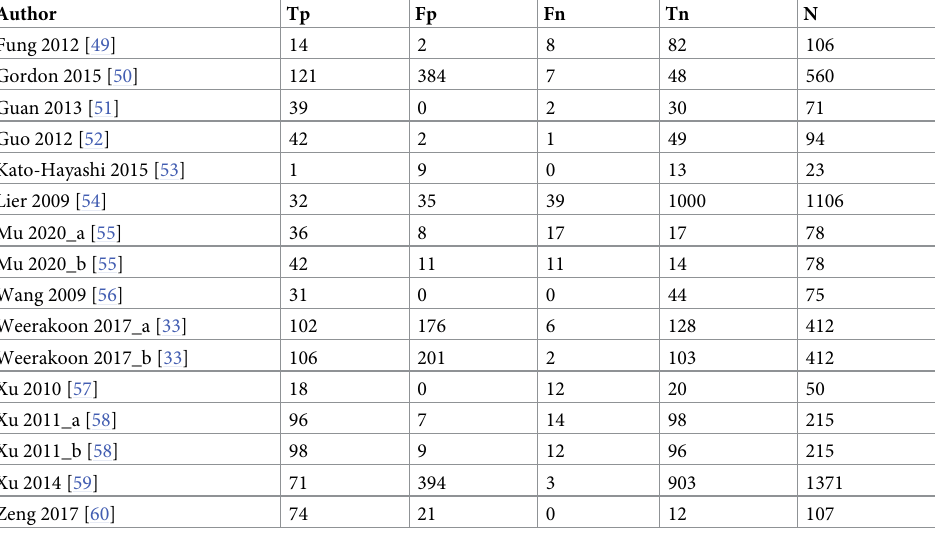
Table 2. Raw data from included studies.